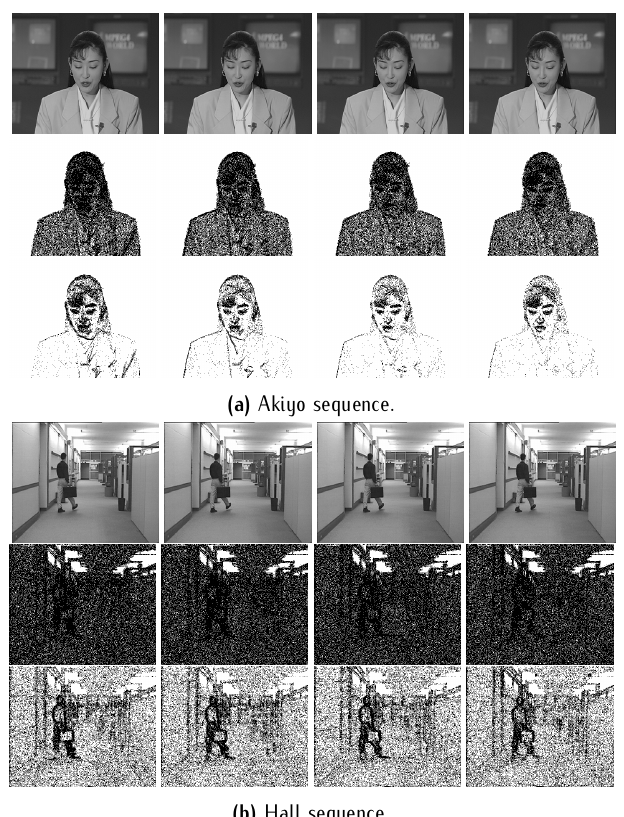
Figure 4. Result of the differential